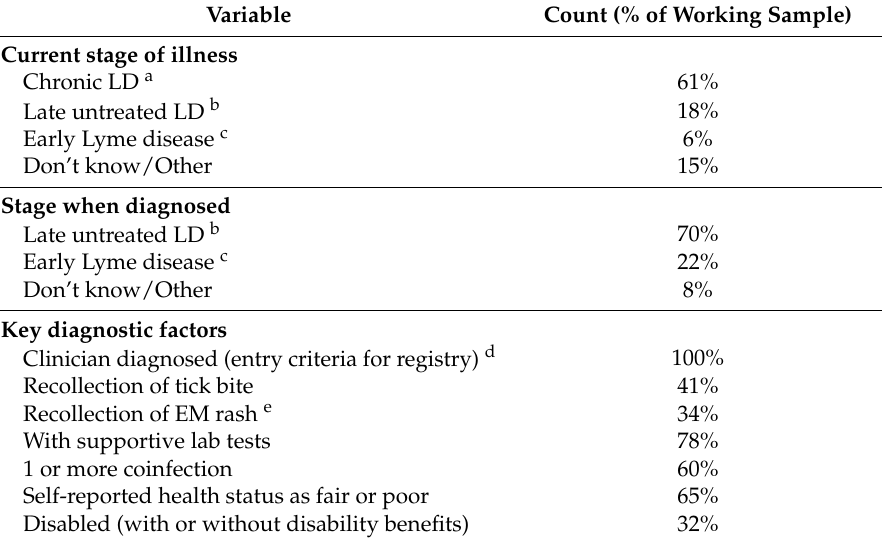
Table 2. Current stage of illness and diagnostic characteristics of